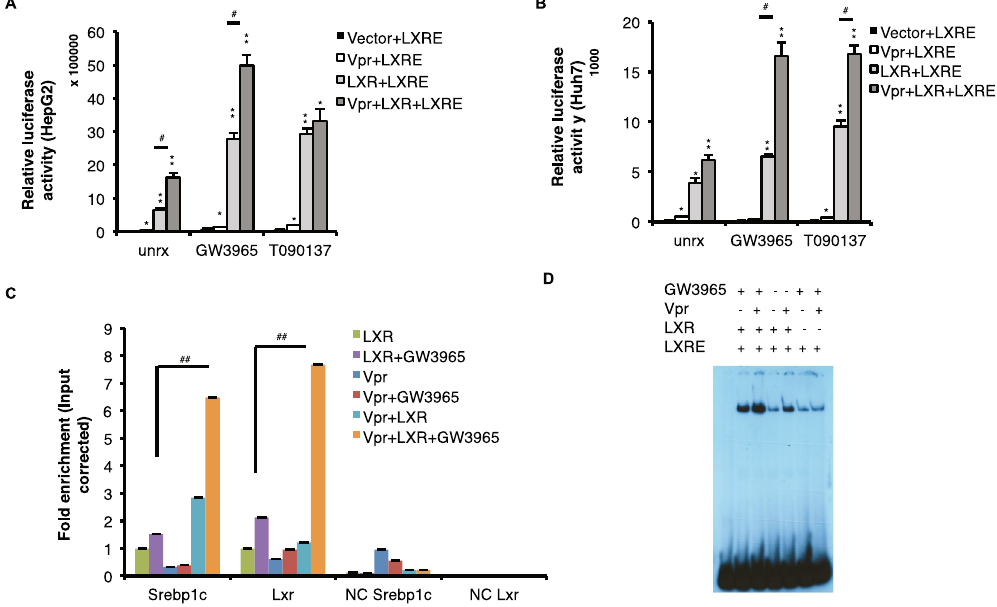
Figure 4. Vpr binds to LXR α and enhances LXRE-dependent promoter activity. ( A ) Vpr increased luciferase activity in HepG2 cells transfected with a LXRE-luciferase construct, with or without exogenous LXR α , in the presence or absence of LXR agonists GW3965 or T090137. ( B ) Vpr increased luciferase activity in Huh7 cells transfected with an LXRE-luciferase construct, with or without exogenous LXR α , in the presence or absence of LXR agonists GW3965 or T0901317. ( C ) Vpr increased association of LXR α with LXRE promoter DNA sequences of Srebp1c (P = 0.007) and Lxr (P = 0.009) in the presence of GW3965, as measured by ChIP (using LXR α antibody) followed by qPCR. Off-target DNA sequences ~2 kb upstream of the LXRE sites were amplified as negative controls (NC). ( D ) Vpr increased binding of LXR α to 32 P-labeled LXRE in nuclear extracts of HepG2 cells, in the presence or absence of GW3965, as measured by gel mobility retardation assay. Data are presented as means ± SE of two replicates, and are representative of two experiments. In A and B, * P < 0.05 and ** P < 0.01 compared to Vector + LXRE; ## P <